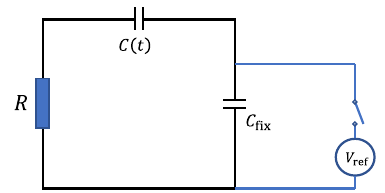
Fig. 1 A schematic for the electric circuit of the device. A capacitor of fi xed capacitance C fix is connected in series to a time-varying capacitor, C t ð Þ , and an electric load, R . The capacitor C fix is initially connected to a